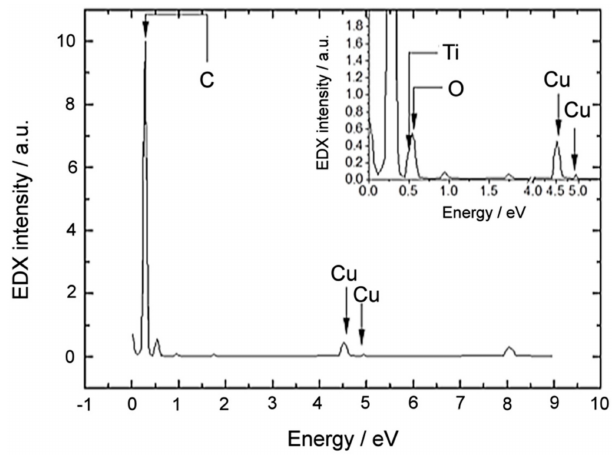
Figure 4. Energy-dispersive X-ray (EDX) spectra acquired right in the core of the nanoparticle.